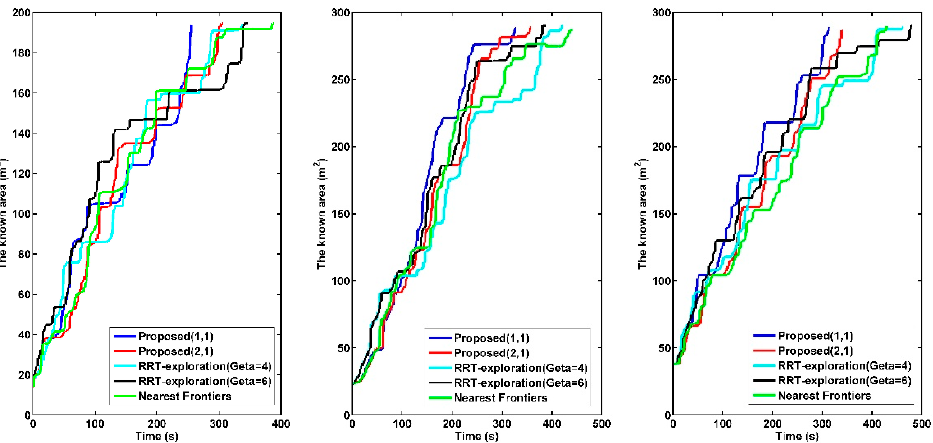
Figure 9. Comparison of the exploration efficiency of different methods in different environments. From left to right: Laboratory, Corridor, and Office.